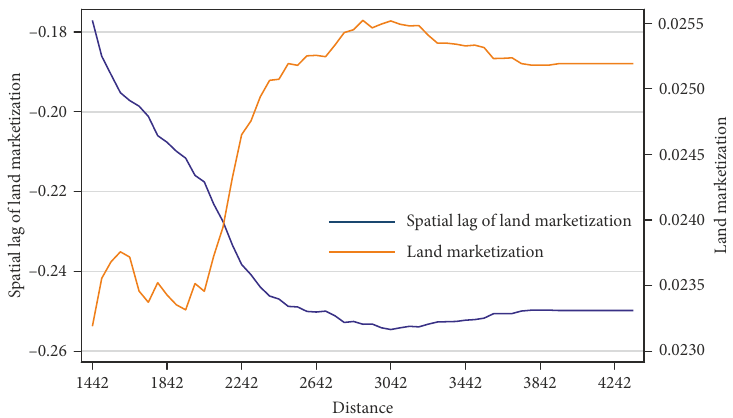
Figure 5. Distance effects of land marketization on